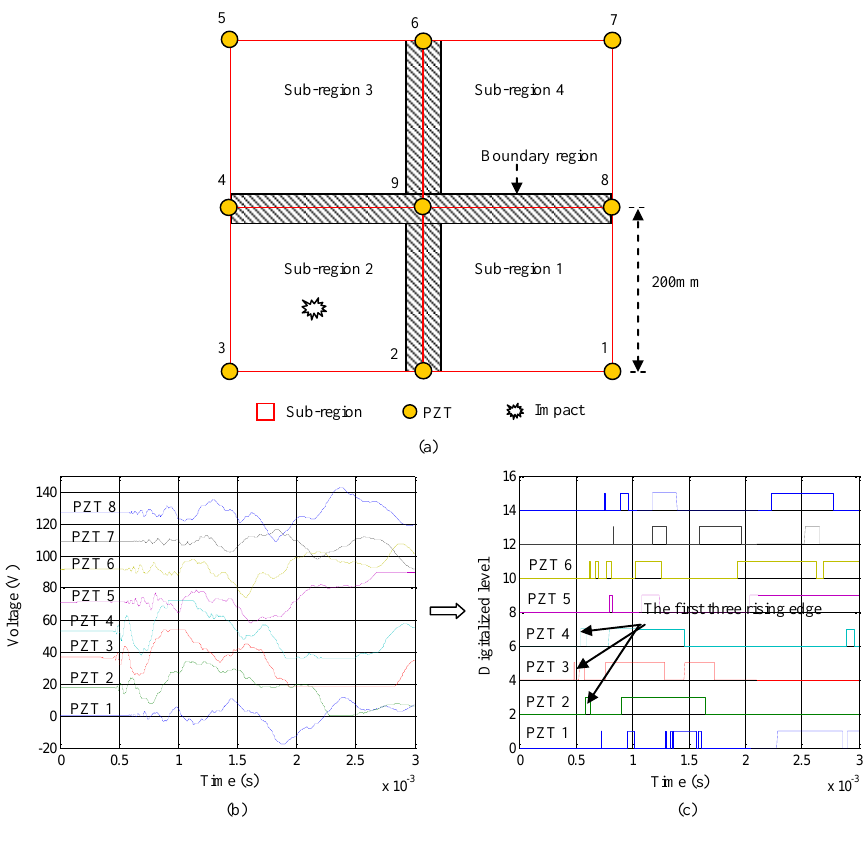
Figure 1. Sub-region dividing based impact alarm region localization method ( a ) PZTs placement on a monitored structure; ( b ) Waterfall plot of impact response signal of PZT1 to PZT8 acquired by Oscilloscope; ( c ) Waterfall plot of digital sequences of PZT1 to PZT8 acquired by digital